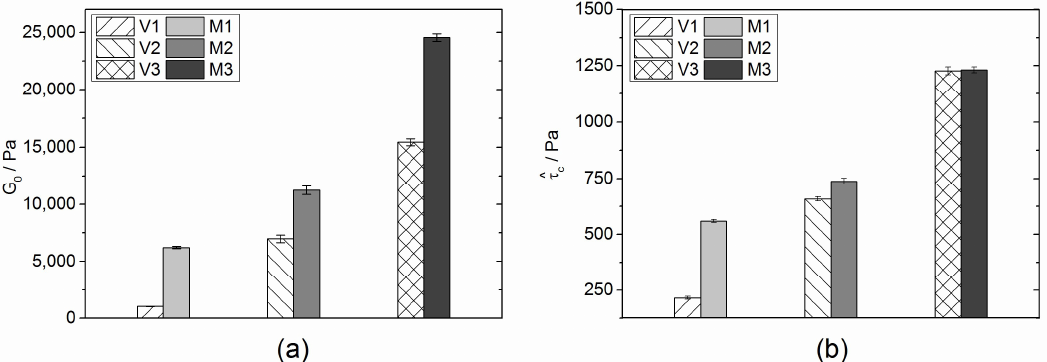
Figure 4. ( a ) Plateau modulus G 0 = G ’ ( f = 1 Hz) determined in the LVE regime; ( b ) Critical stress amplitude ˆ τ c determined from the crossover of G ’ and G ” in amplitude sweep experiments performed at f = 1 Hz. Patterned bars correspond to vehicles, filled bars represent silver pastes.